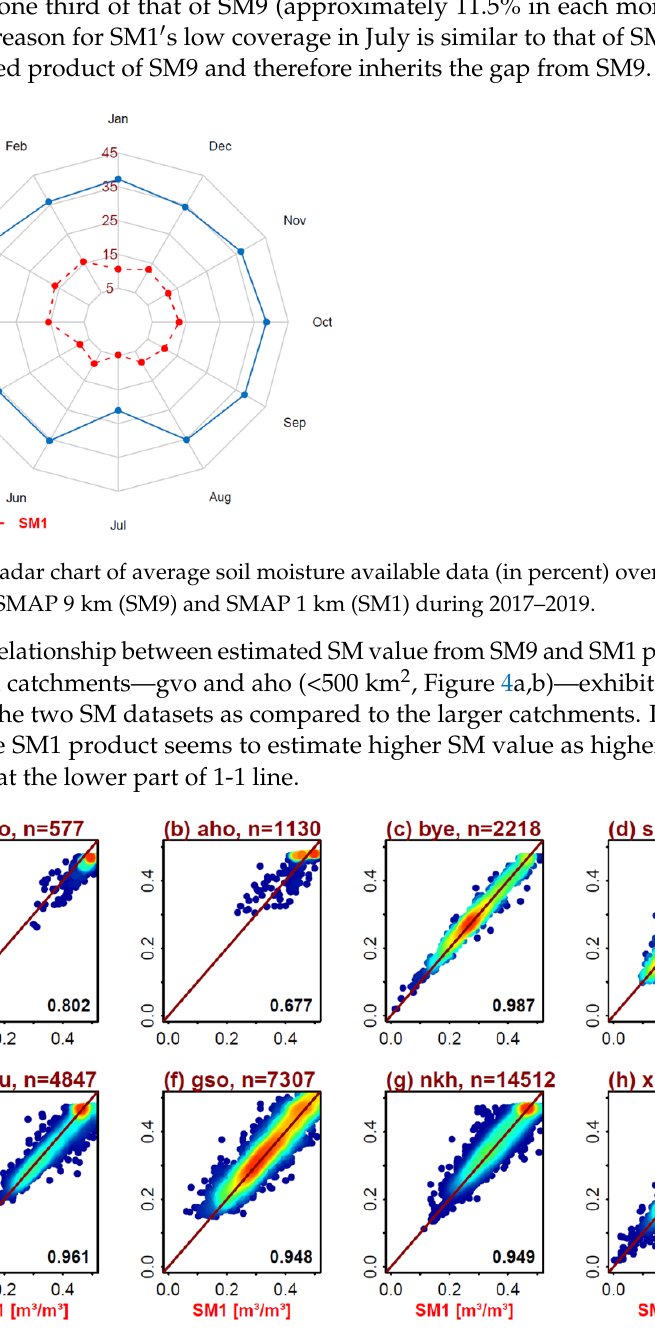
Figure 4. Comparison between soil moisture volume metric estimated at sub-basins over eight catchments ( a ) gvo, ( b ) aho, ( c ) bye, ( d ) slu, ( e ) chu, ( f ) gso, ( g ) nkh, and ( h ) xla using SM9 and SM1. The points colors indicate points density, with more red meaning higher points density. The values in the bottom right indicate correlation values between the two soil moisture datasets. n is the total pair days which both SM9 and SM1 have values at a sub-basin.